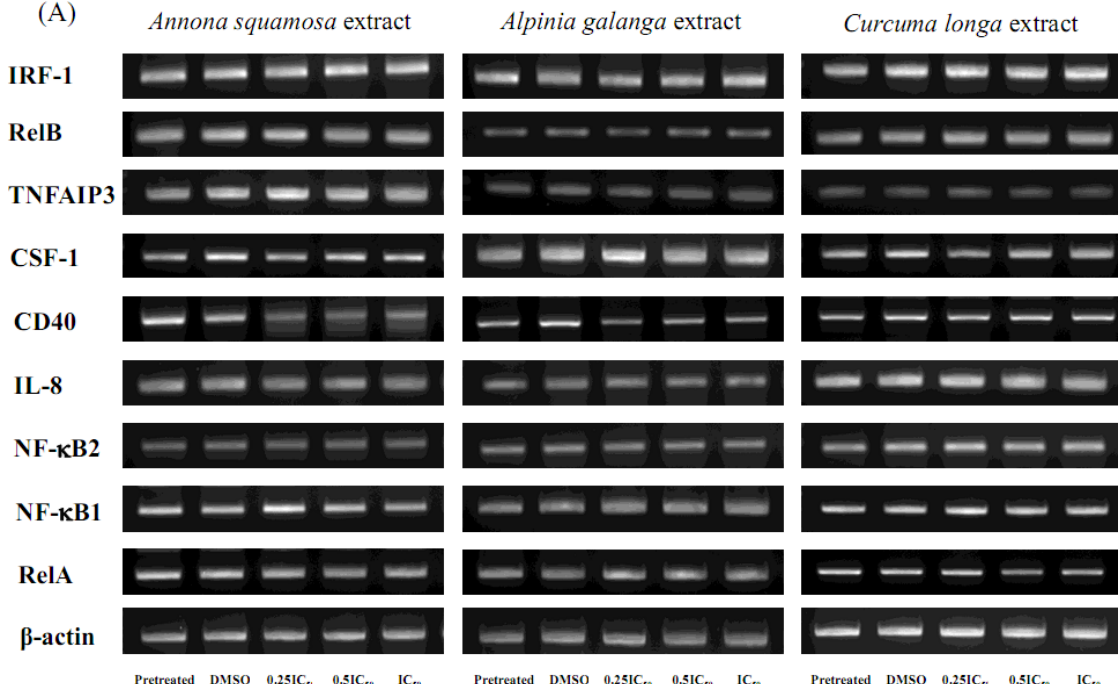
Figure 2. The effect of Thai medicinal herb extracts on the expression of mRNA transcripts of NF- κ B signaling network biomarkers in HaCaT cells pretreated for 12 h with both proinflammatory cytokines and treated for 24 h with increasing concentrations of each herbal extract